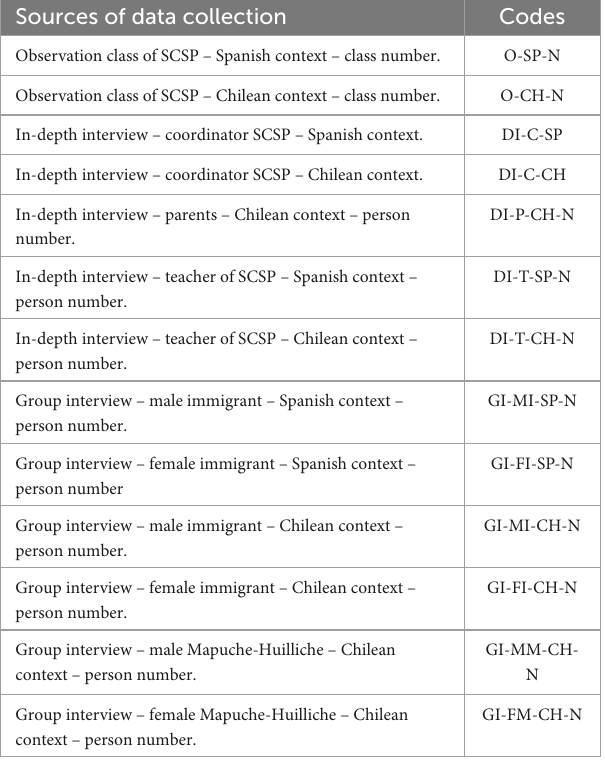
TABLE 2 Sources of data collections and their corresponding codes of analysis. Sources of data